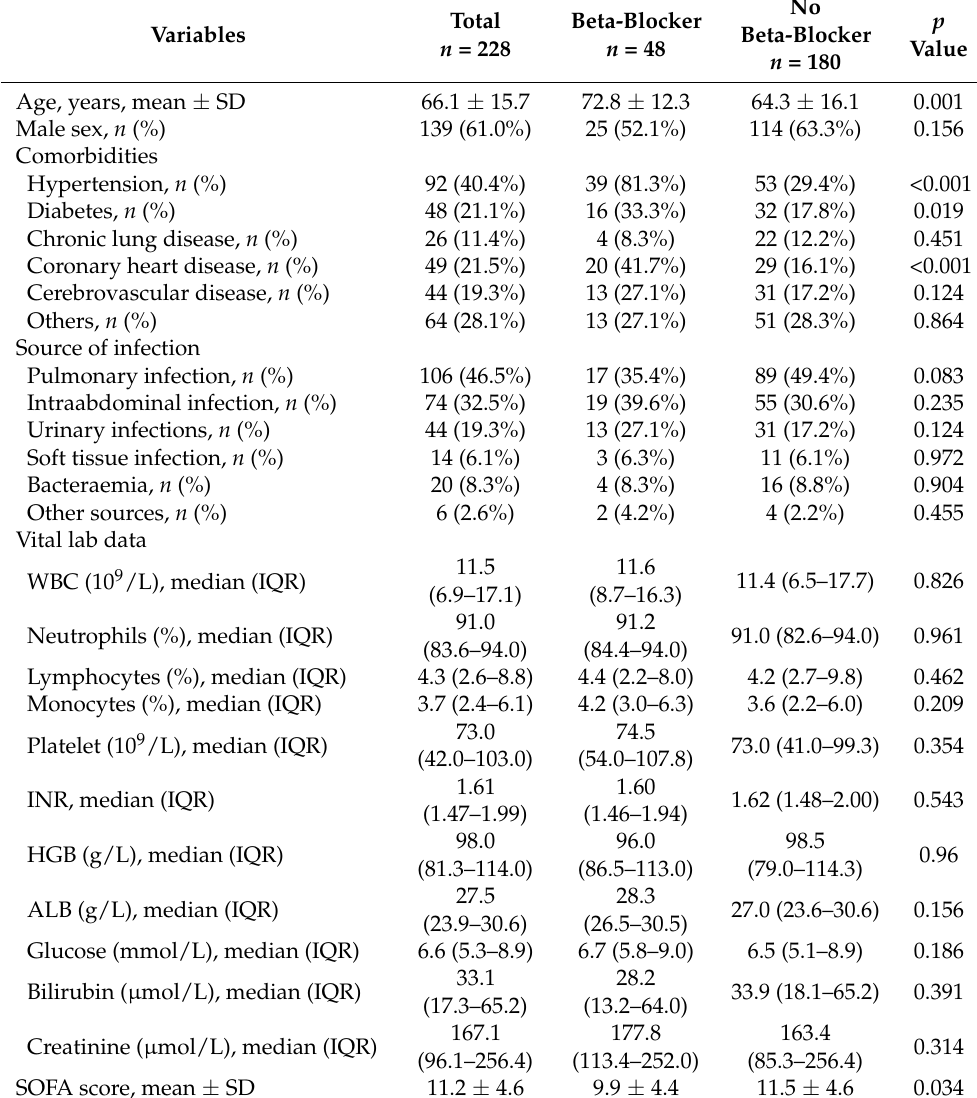
Table 1. Demographic and baseline clinical characteristics of the study